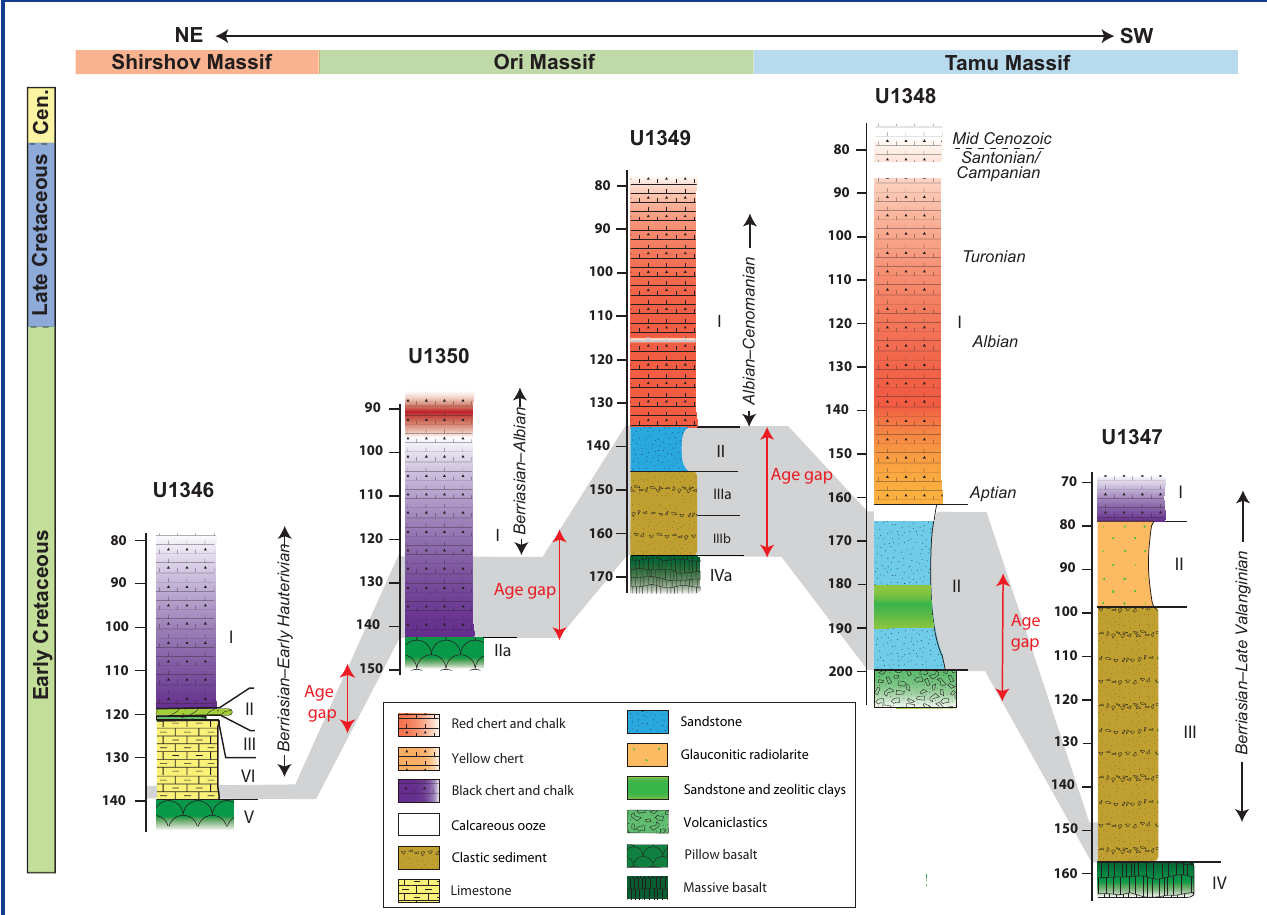
Figure 5. Overview of basal sediment lithology at Expedition 324 sites. Columns are arranged in geographical order from northeast (left) to southwest (right). Ages were deduced from biostratigraphy, as indicated to the right of each column. Vertical position is an indication of biostratigraphic age (left column). Gray band shows the gap between the oldest dated sediment and basement at each